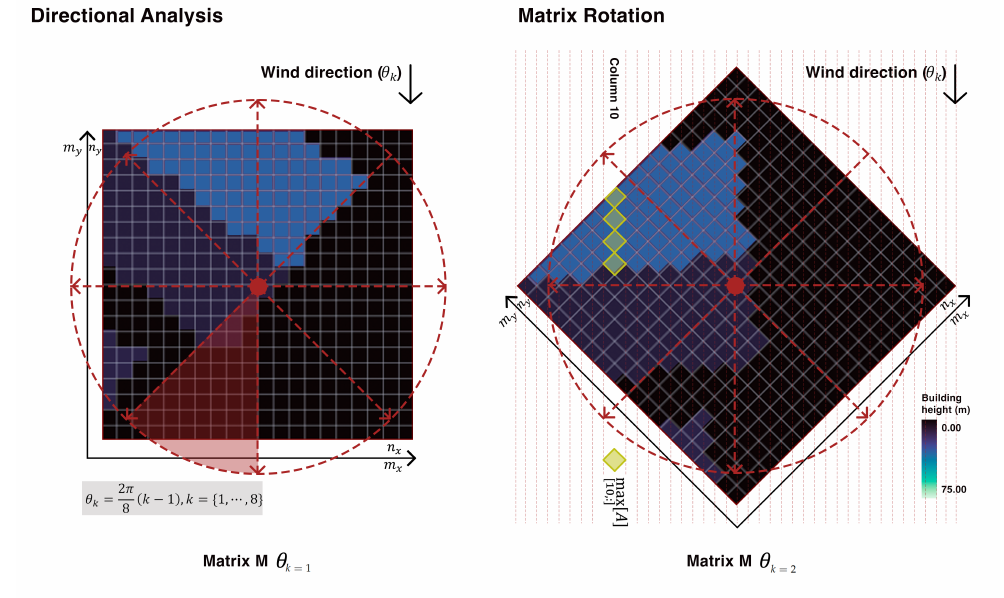
Figure 3. Left : Eight directions are considered; each covers 45 degrees of the plane. Right : Matrix rotation by θ k degrees. Cells highlighted in yellow have the maximum value of this column. See Equation (4) for